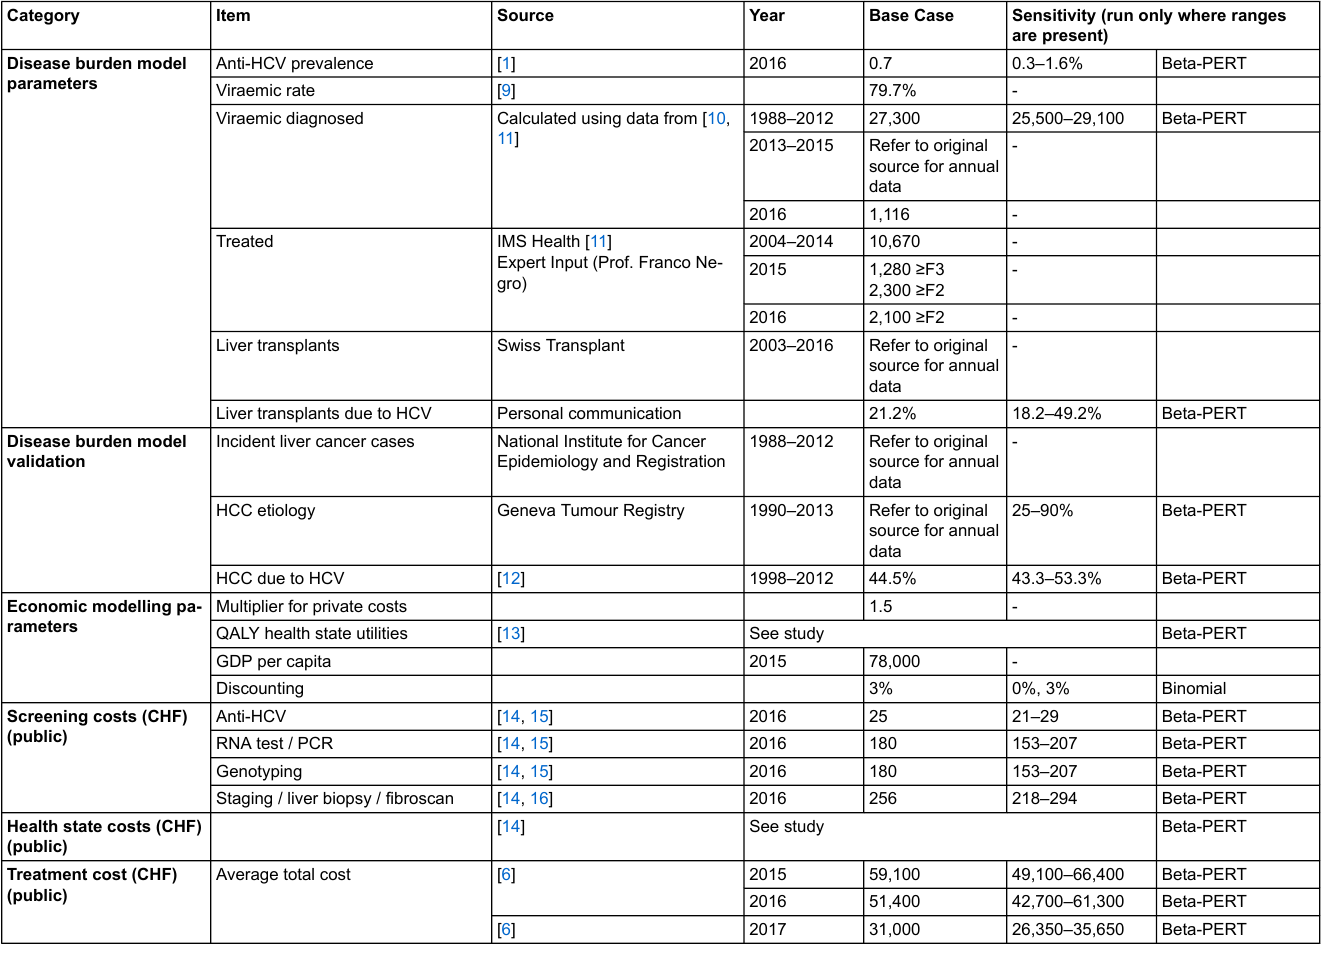
Table 2: HCV disease burden and economic impact module